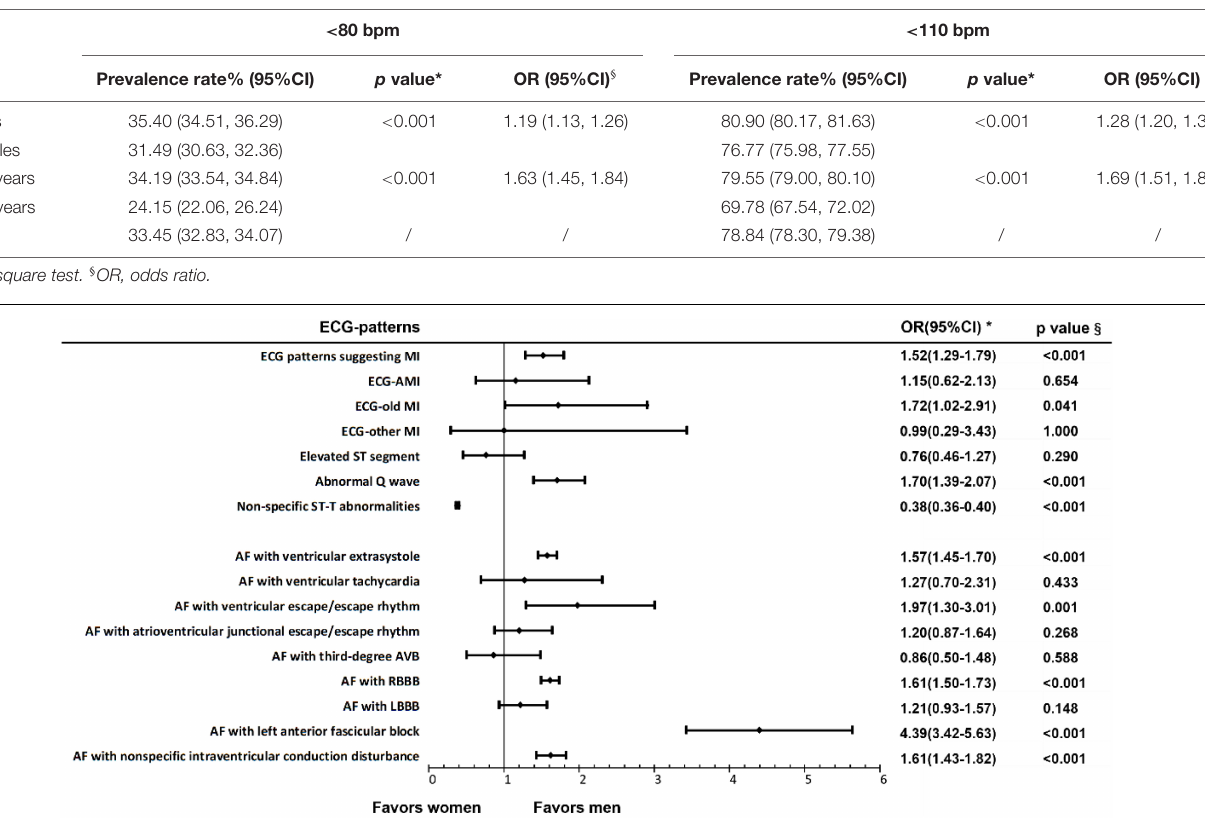
FIGURE 2 | Electrocardiogram patterns suggesting myocardial ischemia and arrhythmias in patients with AF of different sexes. § Chi-square test; *OR, odds ratio.